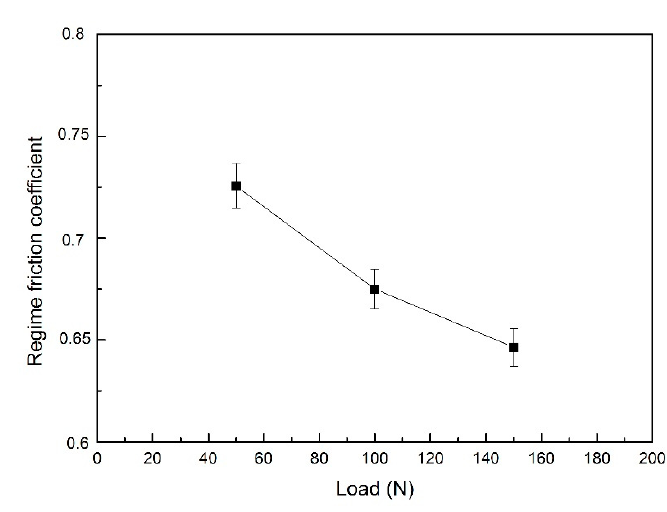
Metals 2021 , 11 , x FOR PEER REVIEW Figure 11. Friction coefficient as a function of the applied load. Figure 11. Friction coefficient as a function of the applied load.